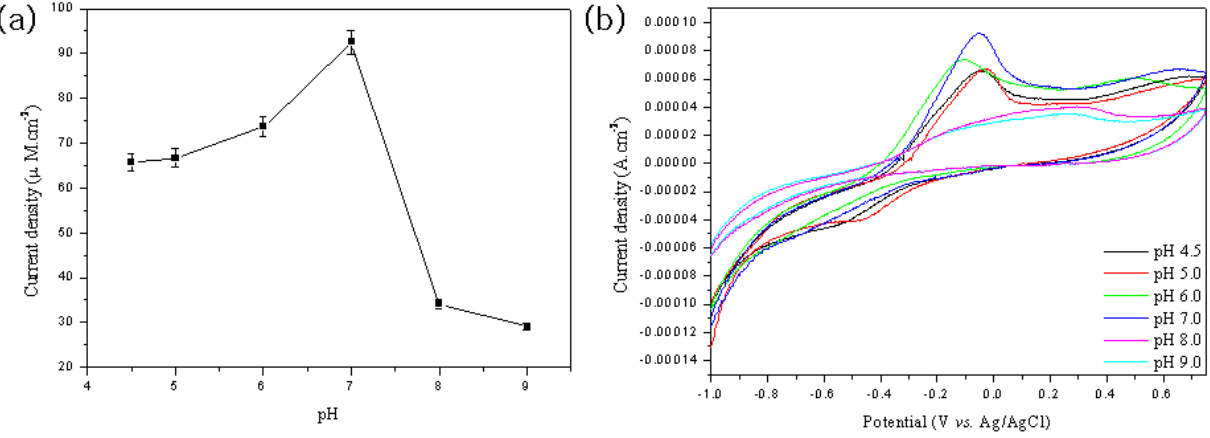
Figure 9. Response sensitivity of the MWNT ion liquid electrode based on tyrosinase as a function of temperature for 0.04 mM phenol in 2.0 mL phosphate buffer (a),